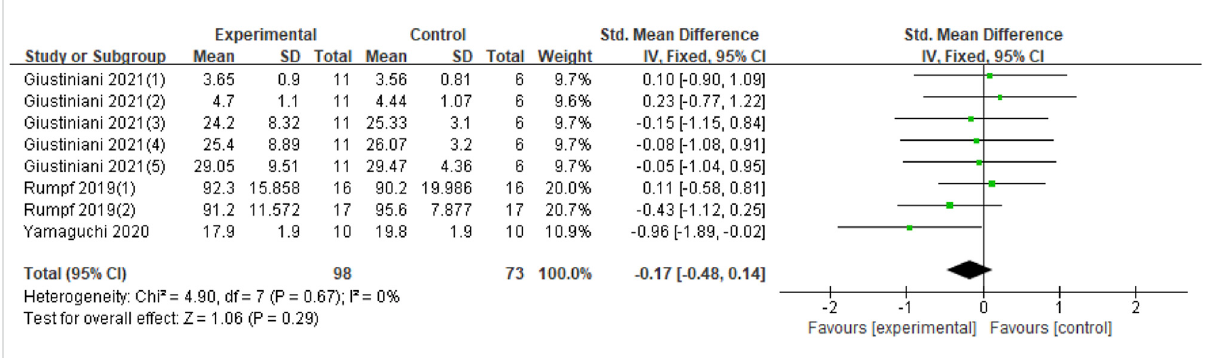
FIGURE 6 Forest plot for the effect of of fl ine stimulation on improving motor performance.